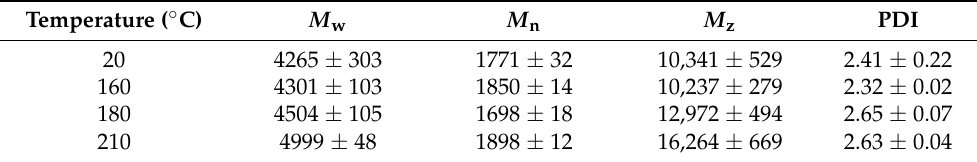
Note: See Table 5 for